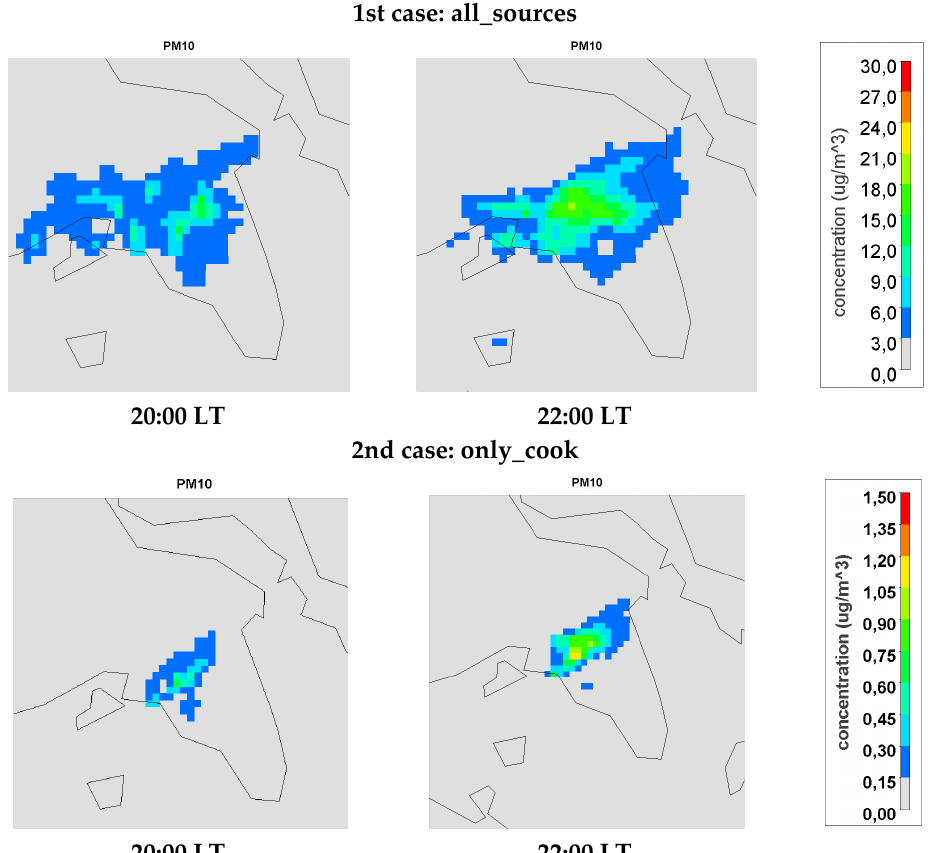
Figure 9. PM10 concentration dispersion at 20:00 LT and 22:00 LT at the GAA, having all emission sources ( top ) and only commercial cooking emissions ( bottom ) as input at the numerical simulations.